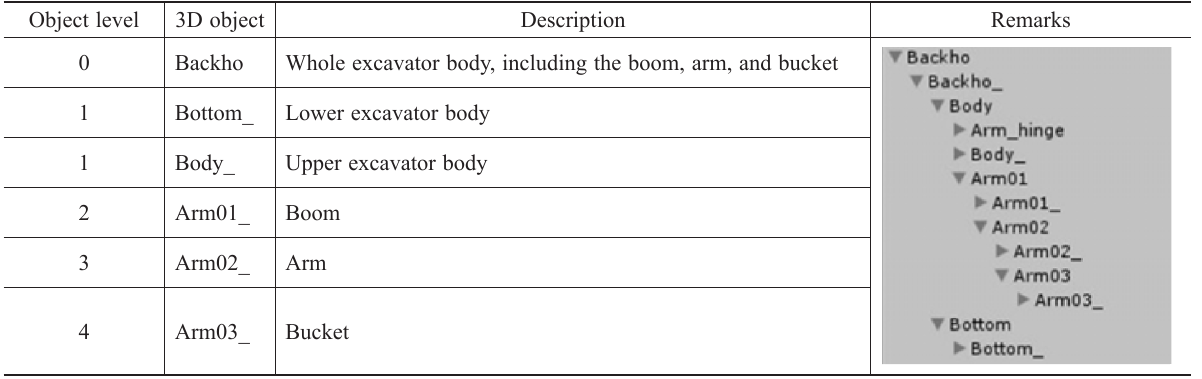
Table 1. A hierarchy of objects for the 3D model components